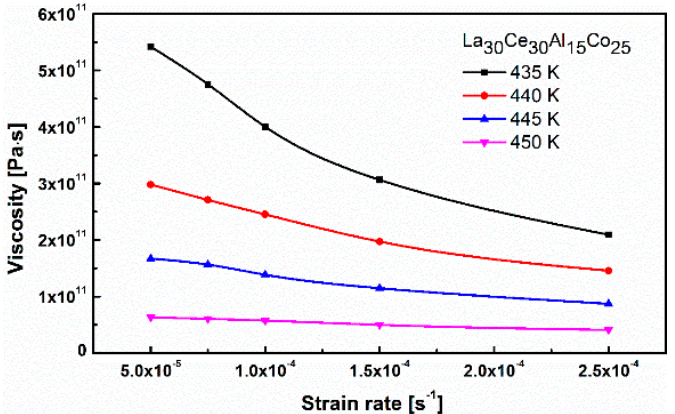
Figure 5. The apparent viscosities of La 30 Ce 30 Al 15 Co 25 metallic glass ribbon as functions of the strain rates at different temperatures.